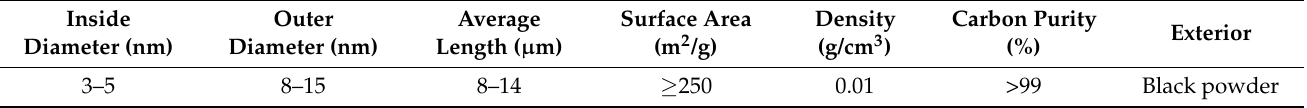
Table 3. Main characteristics of CNTs.